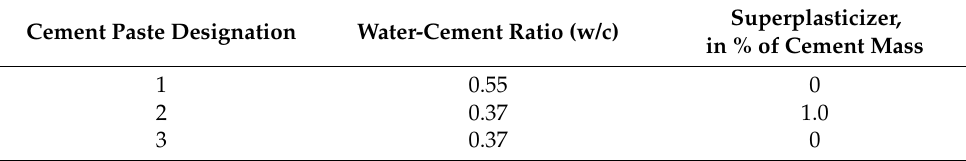
Table 2. Parameters of cement pastes used for LWA immersion.